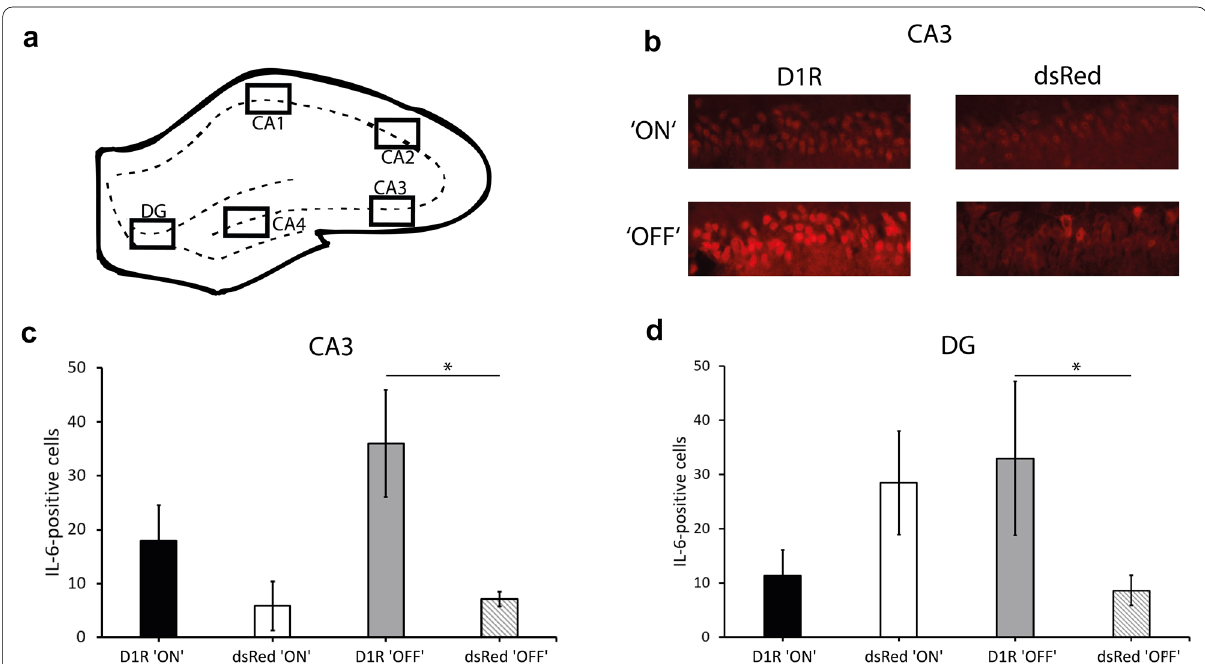
Fig. 3 IL-6-positive cells. Virus over-expression (‘ON’) is terminated (‘OFF’) following doxycycline removal. a Schematic representation of the hippocampus including the regions of interest (hippocampal CA1, CA2, CA3, CA4 and DG). b Representation of IL-6 staining in the CA3 region of the hippocampus. c Amount of IL-6-positive cells in the CA3 is significantly increased in D1R ‘OFF’ subjects compared to controls. d No significant differences in the DG were observable between groups. Means SEM are presented for n 6 subject for each group. *Represent p < 0.05 Bonferroni ± = correction indicating significant differences between relevant